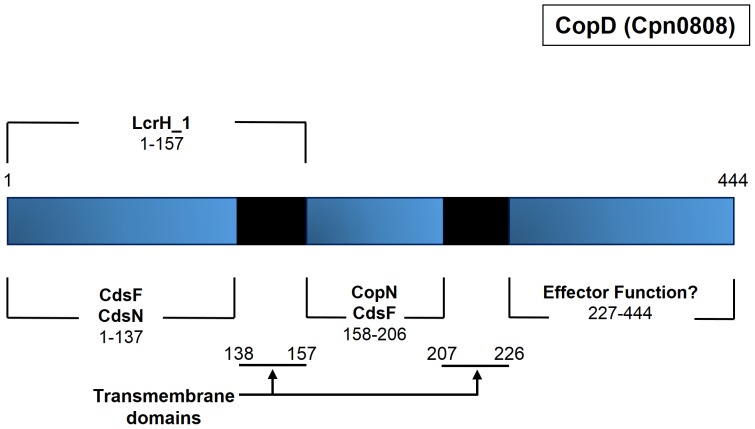
Summary of proposed interactions between CopD and type III secretion proteins.Interactions identified through Glutathione-S-Transferase pull down assays mapped to a topographic overview of CopD.